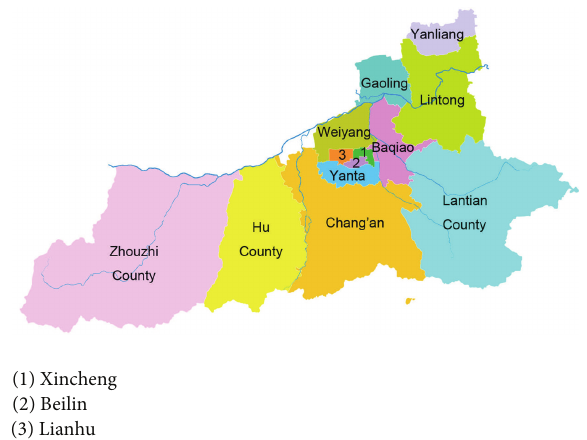
Figure 1: Geographical distribution of different administrative area in